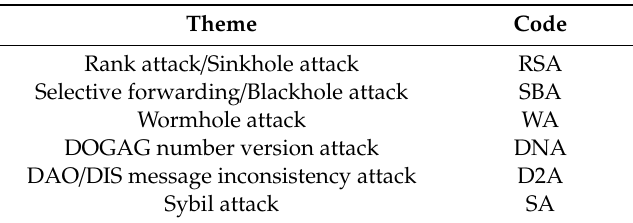
Table 5. Theme coding.